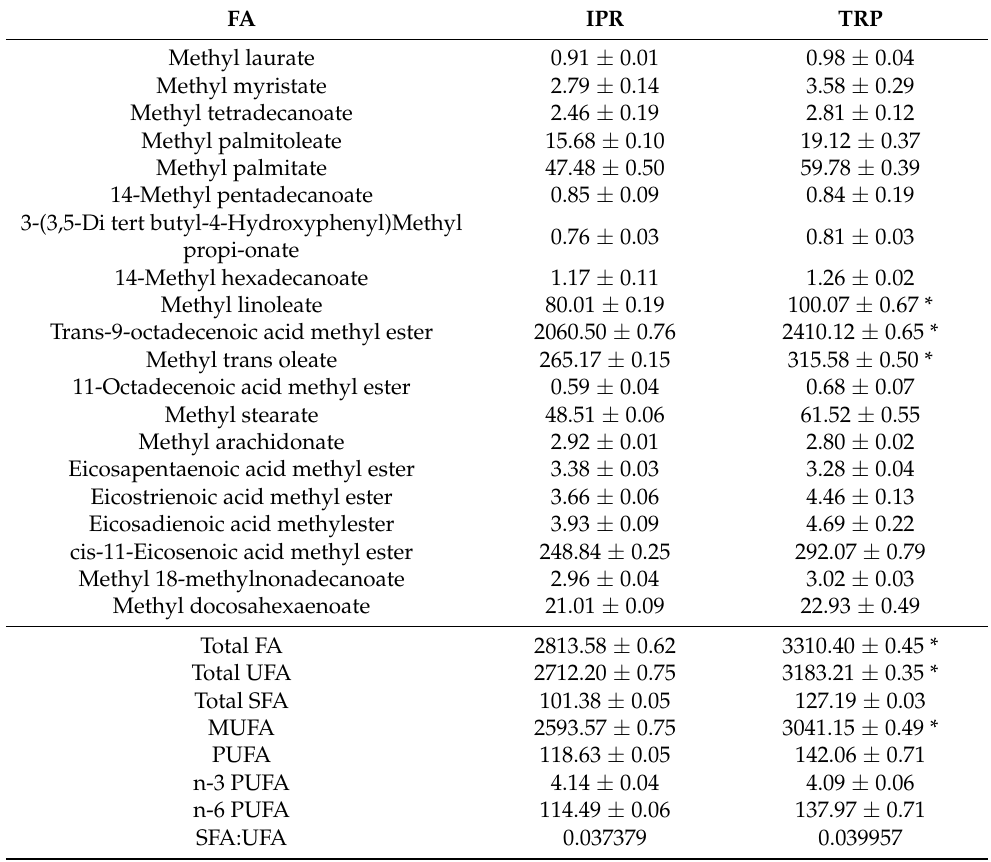
Table 8. Fatty acid composition of the muscles of fish cultured in IPR and TRP (mg/kg dry